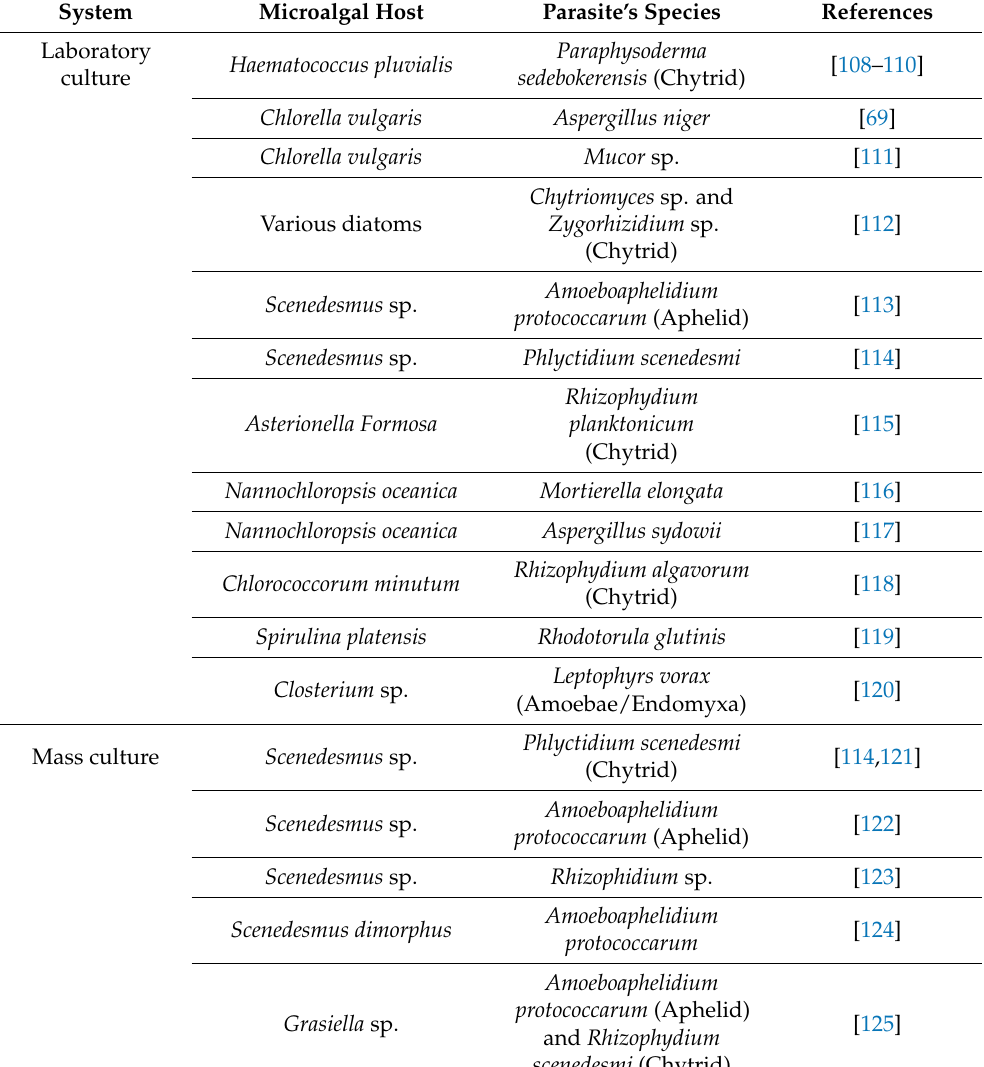
Table 1. Parasites reported for microalgae in laboratory culture and open